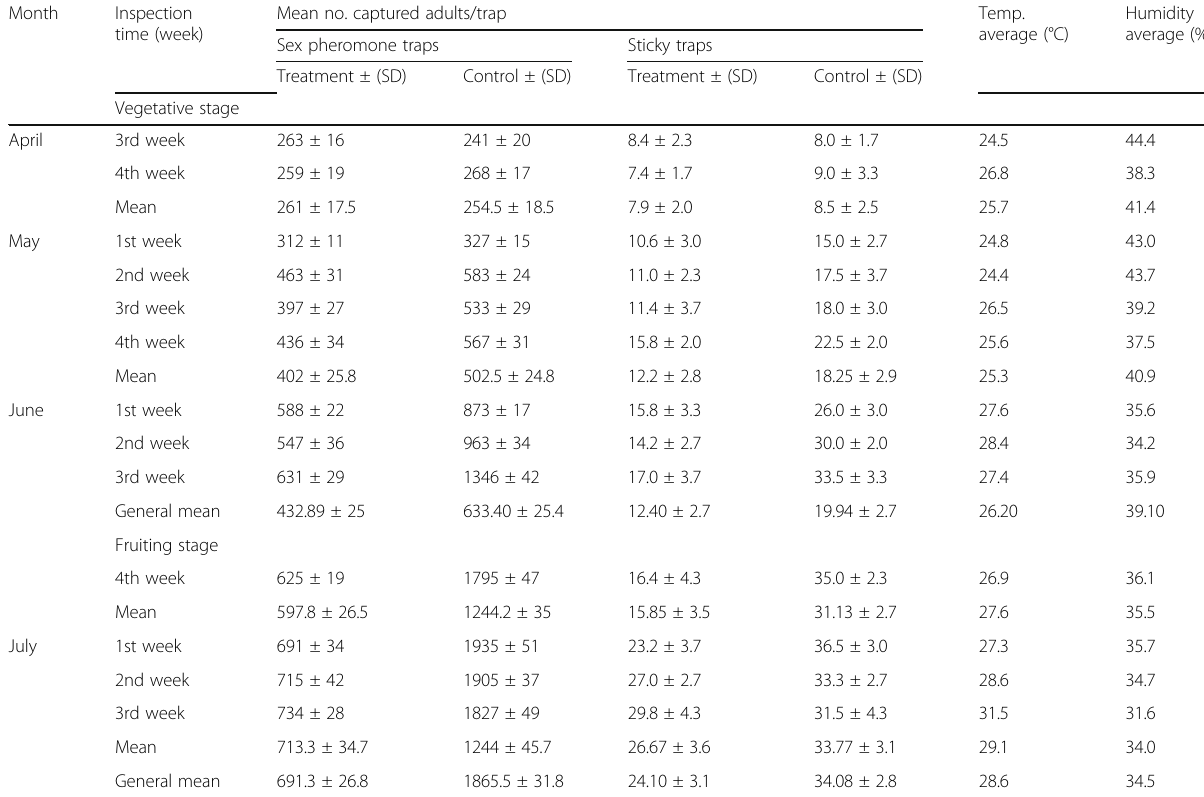
Humidity average (°C) average (%)